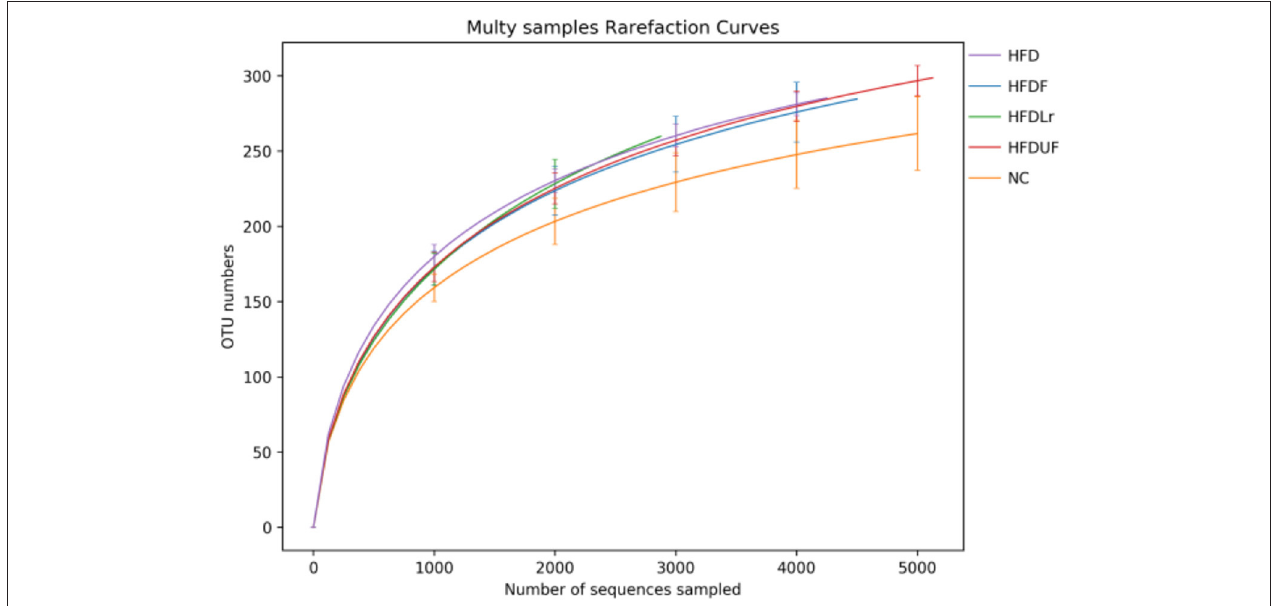
FIGURE 6 | Rarefaction curves derived from the 16S rRNA sequencing of the microbial species in each sample group.